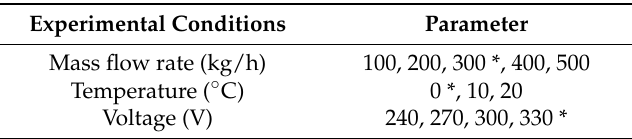
Table 3. PTC heater experimental